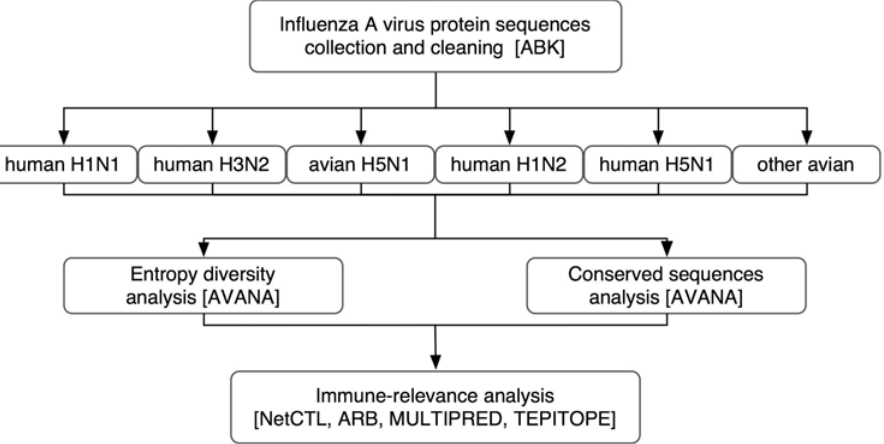
Figure 1. An overview of the methodology of this study.